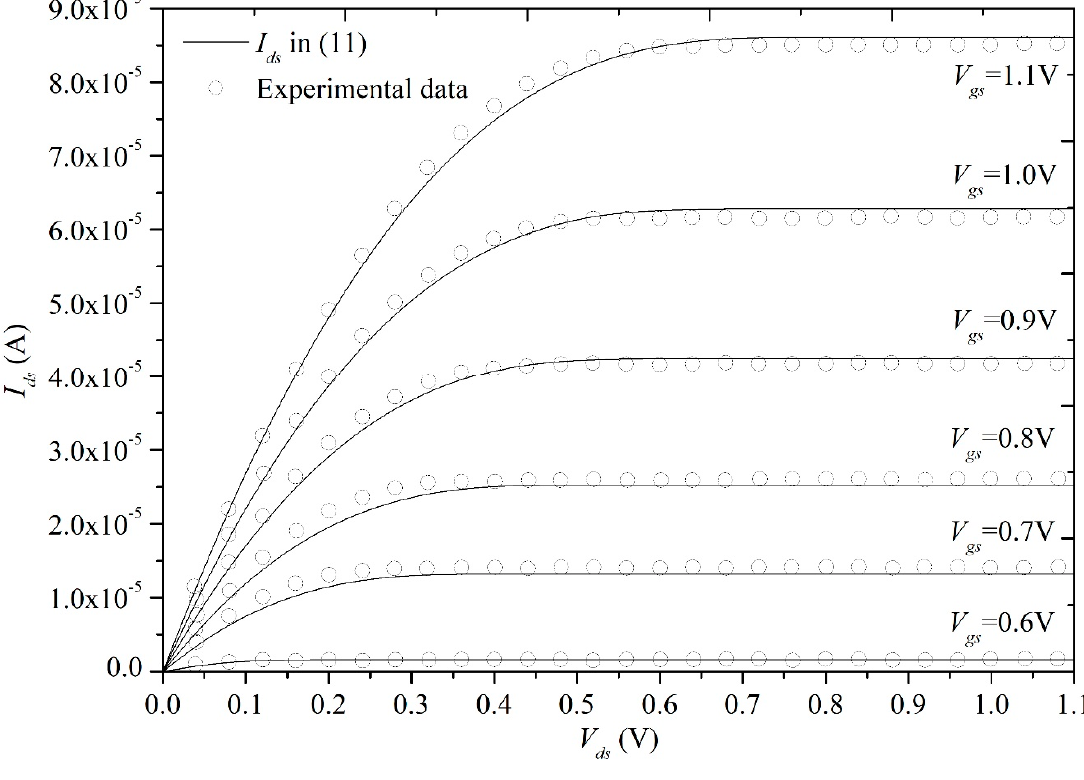
Figure 8. Comparisons of output characteristics between our drain current model results and long-channel experimental data [22] from Khandelwal et al.